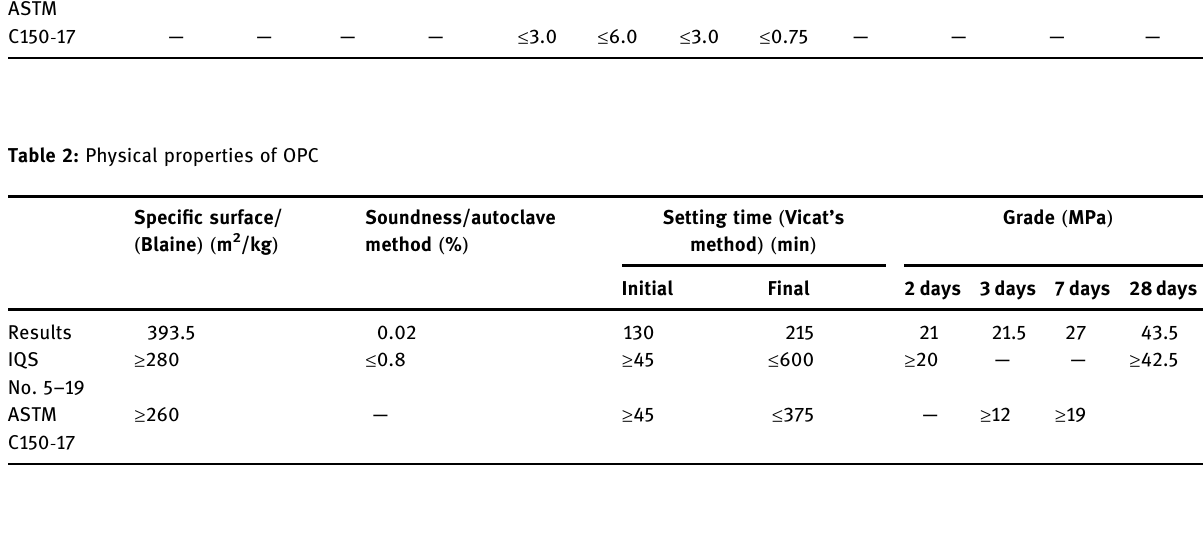
Table 3: Sieve analysis of FA and